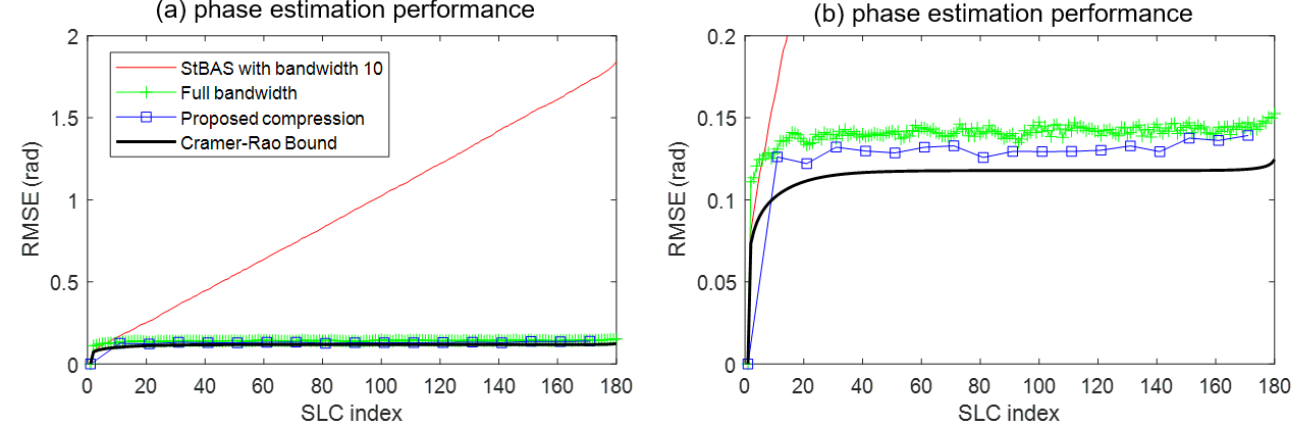
Figure 2. Comparison scenarios on phase linking performances for DS targets. The RMSE of phase estimation is used as a performance indicator; ( b ) is the zoom version at a different scale of ( a ) to appreciate the